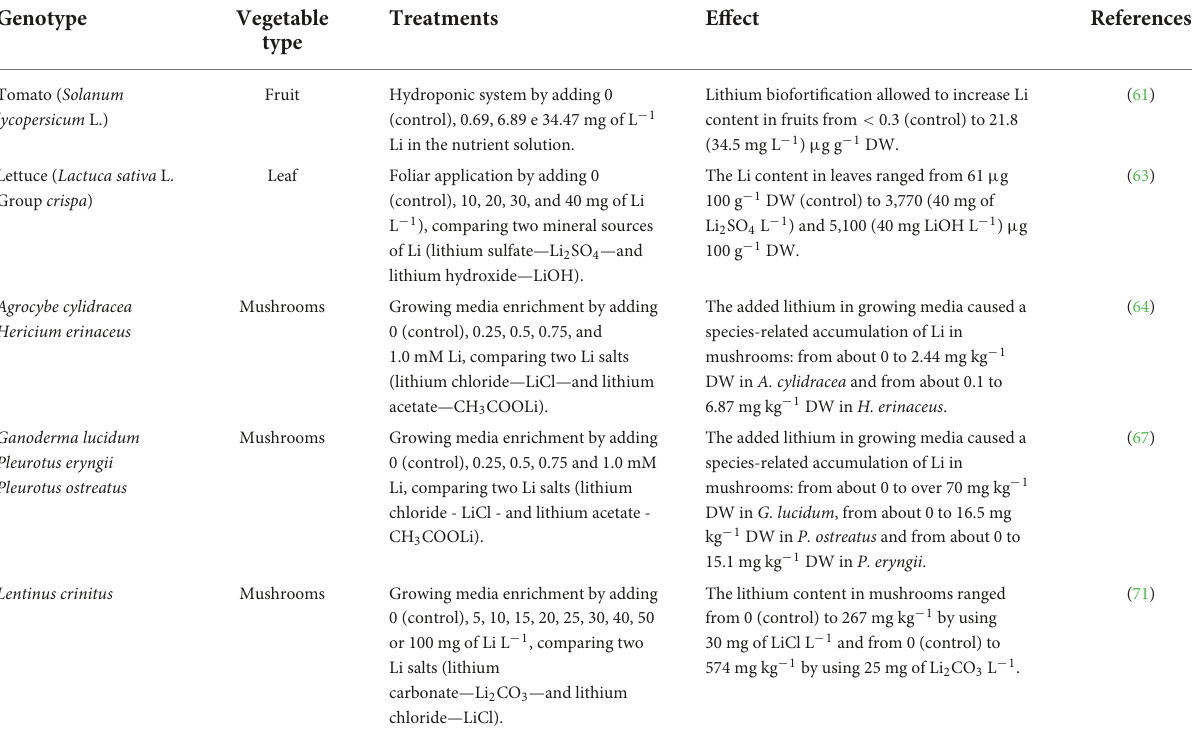
TABLE 3 Lithium biofortified vegetable products indicated to people for whom it is desirable to promote mental health.